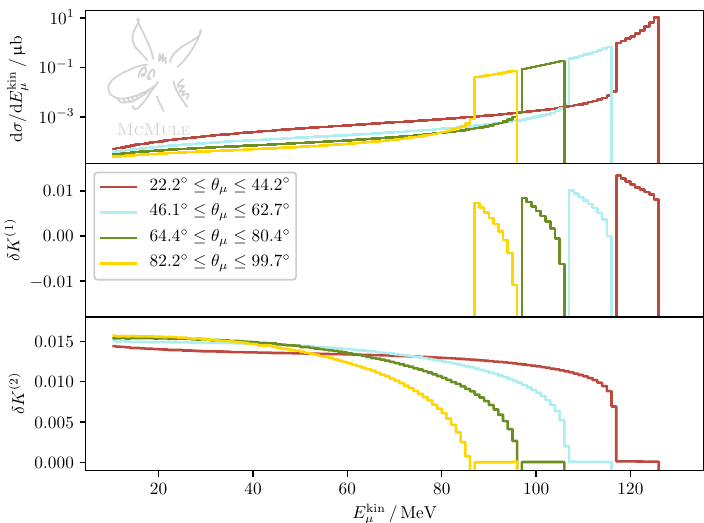
Figure 12: Differential cross section d σ/ dE kin momentum 210 MeV, at LO (green) and NNLO (red) with K factors. Results are shown separately for different bands of the scattering angle θ